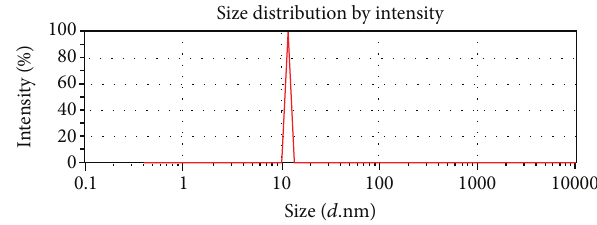
Figure3:ParticlesizedistributionofMn-dopedZnSQDsmeasured by DLS.